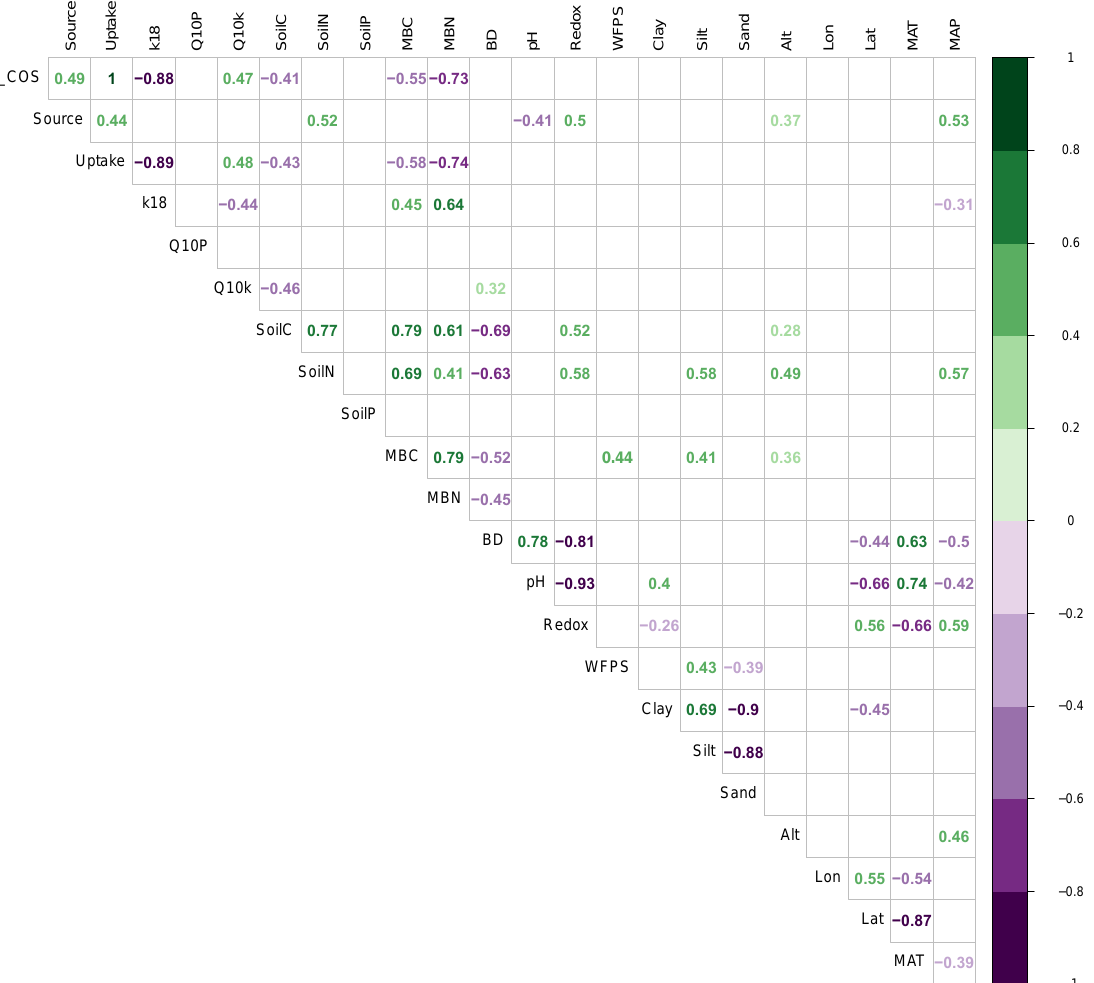
Figure 4. Spearman correlation coefficients (rho) between variables describing soil COS fluxes and soil properties. “F_COS” is the net COS flux at 18 ◦ C, “Source” is the gross COS production rate at 18 ◦ C, “Uptake” is the gross COS uptake rate at 18 ◦ C, “ k 18 ” is the hydrolysis rate constant at 18 ◦ C, “ Q 10 P ” and “ Q 10 k ” are the Q 10 of the source and the hydrolysis rate, “SoilP”, “SoilC” and “SoilN” are the respective soil phosphate (P), C and N content, “MBC” and “MBN” are the respective microbial biomass C and N contents, “BD” is the bulk density, “Redox” is the potential redox, “WFPS” is the water filled pore space, “Alt” is the site altitude, “Lon” is the site longitude, “Lat” is the site latitude and “MAT” and “MAP” are the respective mean annual temperature and precipitation for each site. Only significant correlations are shown ( P <